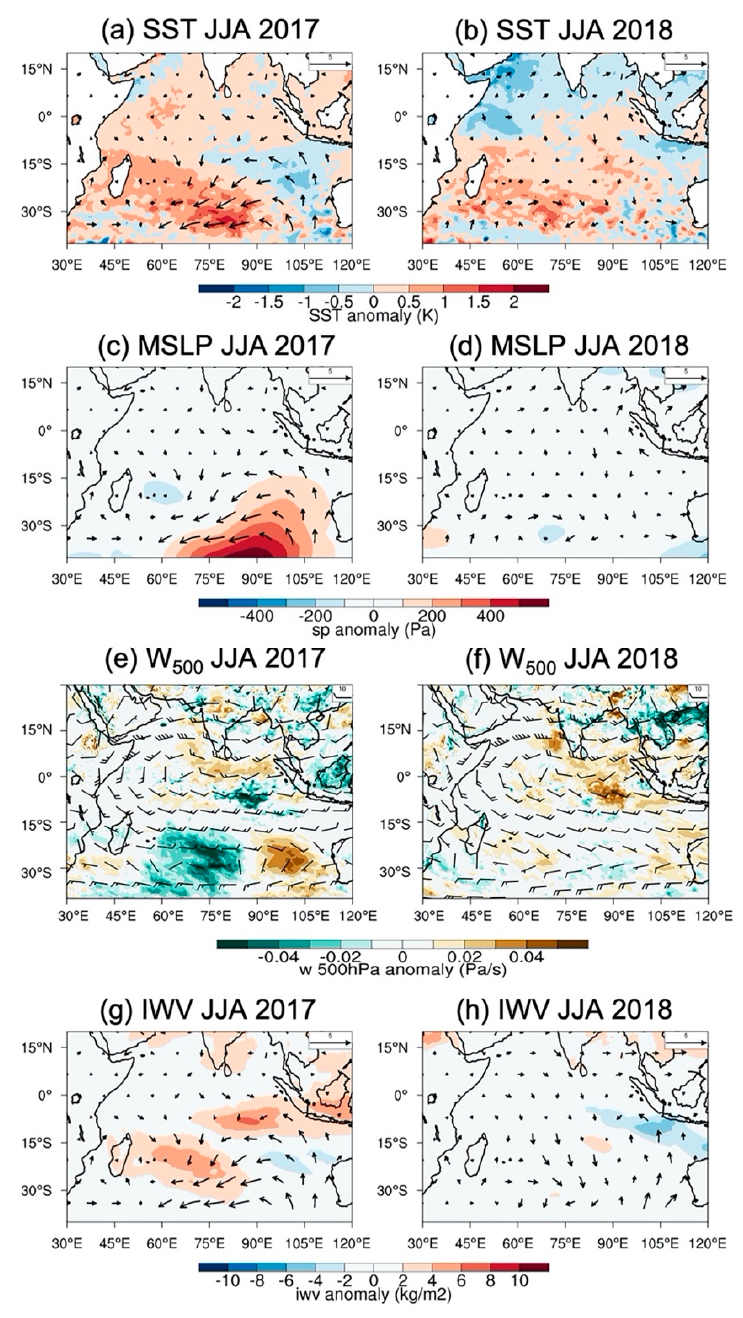
Figure 8. ( a , b ) Sea Surface Temperature (SST), Mean Sea Level Pressure (MSLP), Vertical velocity at 500 hPa (W) and Integrated Water Vapour (IWV) anomalies in summer (DJF) 2017 ( left panel ) and 2018 ( right panel ), computed from ERA5 reanalysis data over the period 1990–2020. As in Figure 7, but for winter (JJA) 2017 and